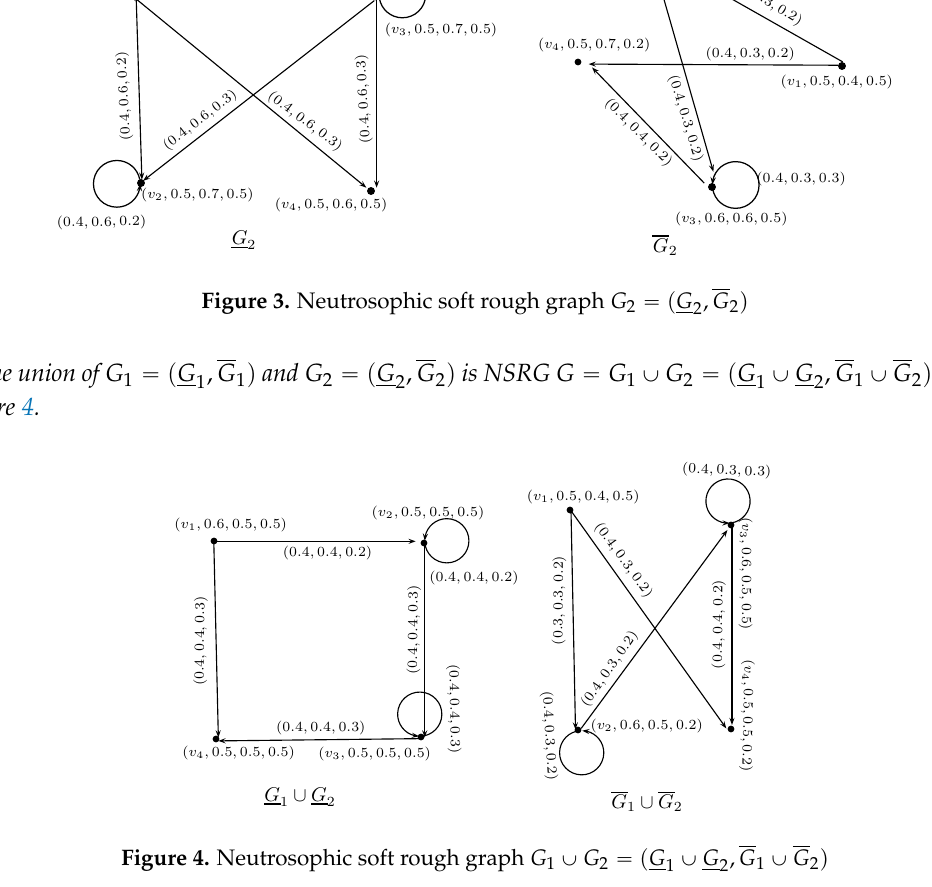
Figure 2: Neutrosophic soft rough graph G 1 = ( G